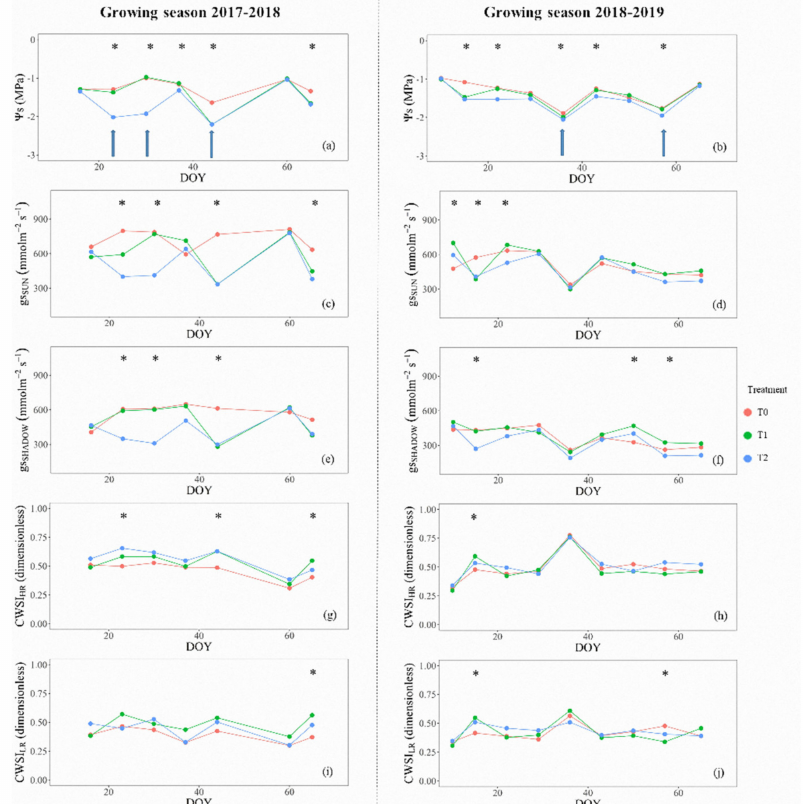
Figure 5. Seasonal evolution of averaged values of midday stem water potential, stomatal conductance, and crop water stress index of cherry trees ‘Regina’, for each post-harvest irrigation treatment (control: T0 ( Ψ s ≥ − 1.0 MPa); low–medium water stress: T1 ( − 1.0 ≥ Ψ s ≥ − 1.5 MPa), and high (severe) water stress: T2 ( − 1.5 ≥ Ψ s ≥ − 2.0 MPa). (Growing seasons 2017–2018 = ( a , c , e , g , i ); Growing season 2018–2019 = ( b , d , f , h , j ). Subscripts HR and LR, denote that the thermal images were shot from a high- and low-resolution TIR camera. (* Significant Tukey’s HSD test p < 0.05). The arrows indicate the irrigation events for